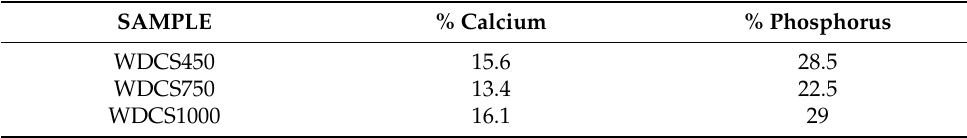
Table 4. Percentage of Calcium and Phosphorus within the